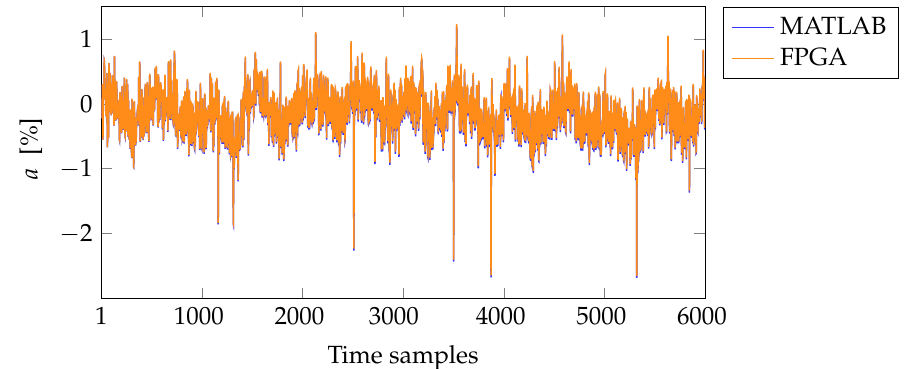
Figure 20. Comparison of MATLAB and testbench time responses for a 4th-order regulator.